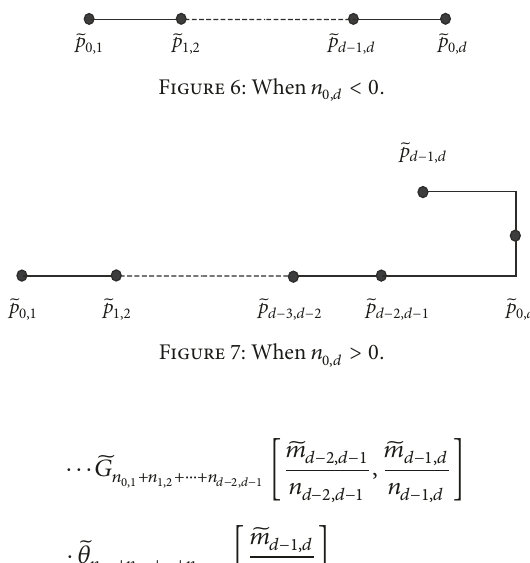
Figure 5: End point when 𝑛 0,𝑑 > 0 .